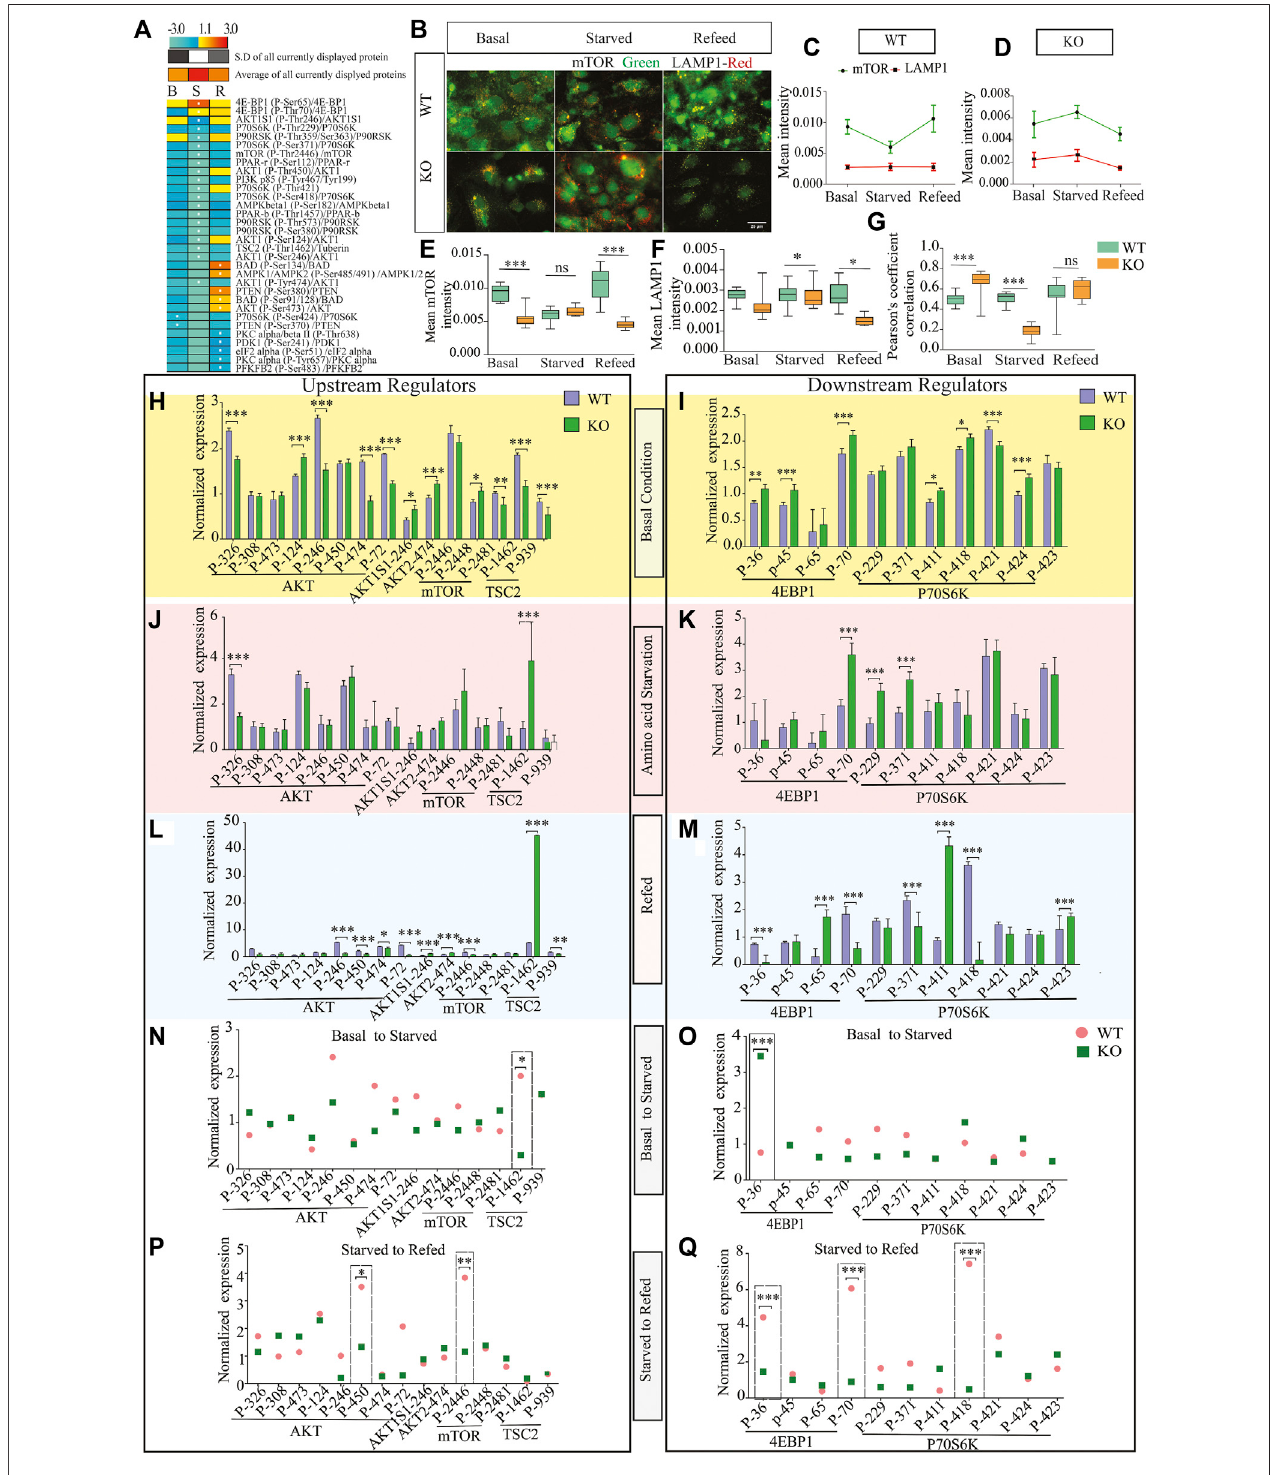
FIGURE 2 | Dysregulation of the mTOR signaling pathway. (A) . Heat map representation of phosphoprotein ratio detected in full moon Biosystems mTOR phospho-protein array. Fold change was calculated after normalizing the average signal cor-responding to the median signal for each group, and the ratio has been calculated as KO vs. WT signals. Proteins that have shown at least 2-fold up or downregulation were included. (B) . KO cells show less co-localization of mTOR (green) with the lysosome (LAMP1, red) in refed and starved conditions than WT cortical cells. Scale bar represents 10 um. (C,D) The total intensity of mTOR and LAMP1 was measured with cell pro fi ler using immunostaining images in WT (C) and (D) KO. Graphs represent mean ± SEM; * p < 0.05, ** p < 0.01, Student ’ s t-test ( n = 15 – 17